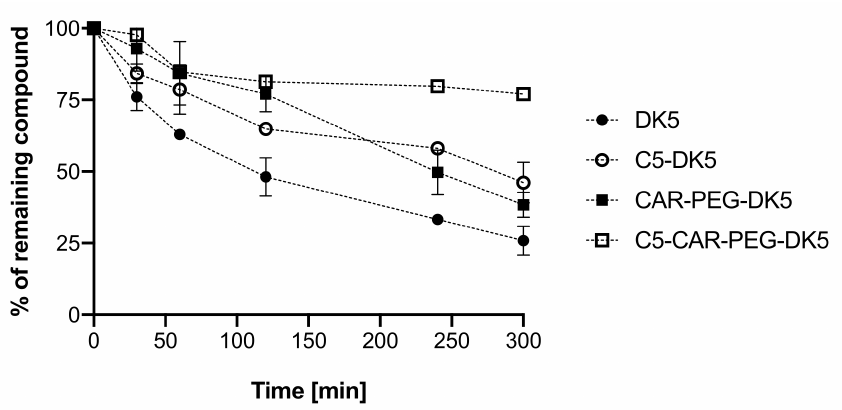
Figure 3. Evaluation of serum stability of the selected compounds.